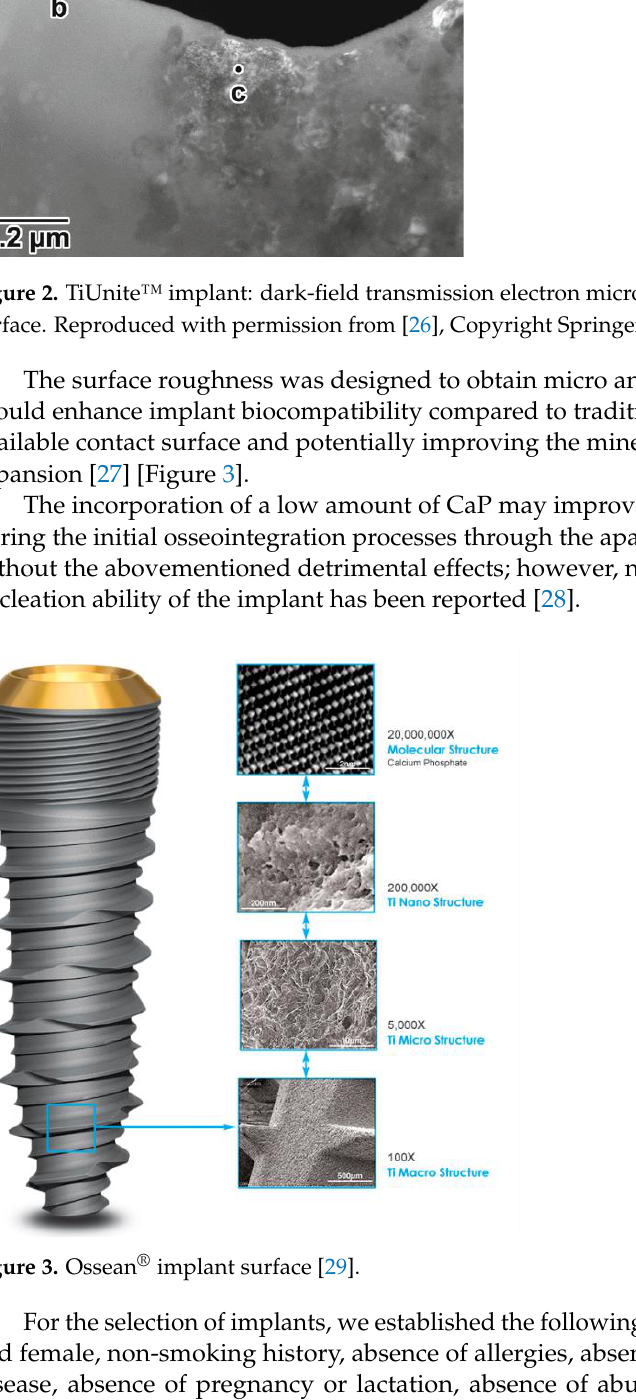
Figure 3. Ossean ® implant surface [30].